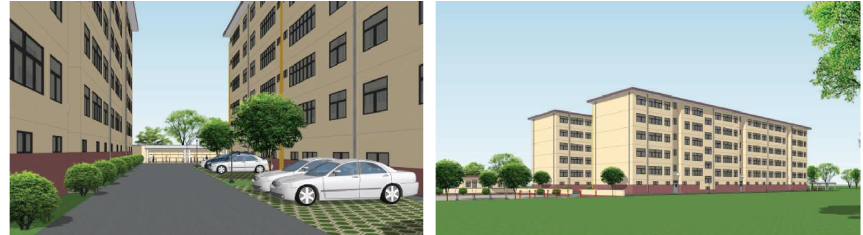
Figure 11: Schematic diagram of building style transformation of